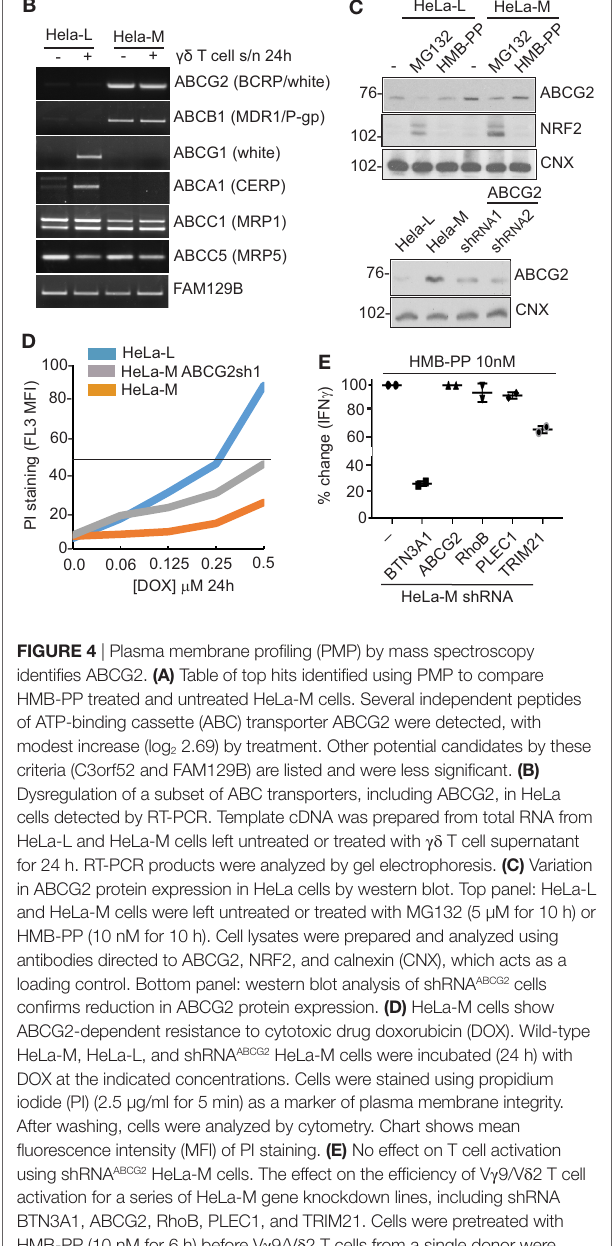
0.0 0.06 0.125 0.25 0.5 [DOX] µ M 24h